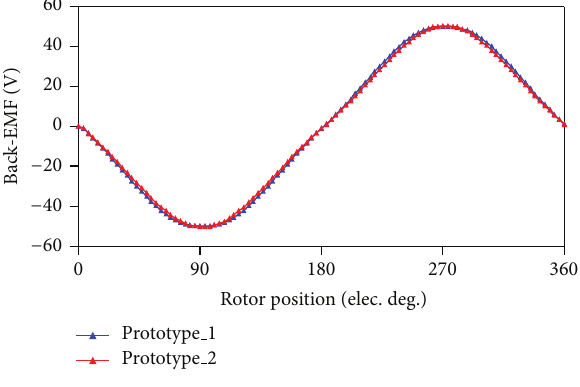
Figure 4: Comparison of